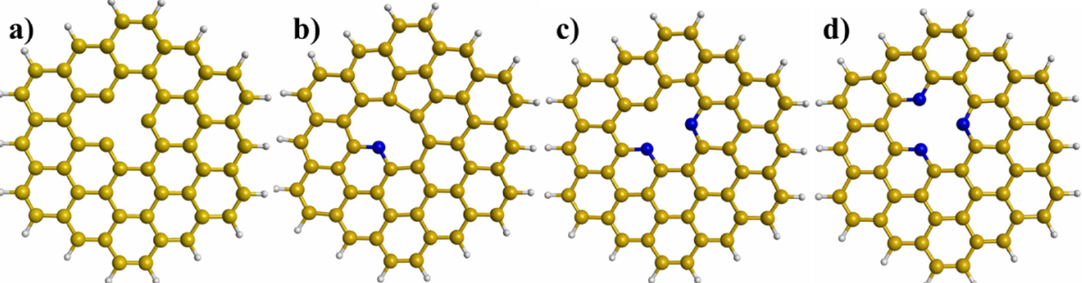
Figure 1. Structures of graphene with different defects: ( a ) Graphene with a vacancy, ( b ) pyridinic N-doped graphene (PNG) with an N atom, ( c ) PNG with two N atoms, and ( d ) PNG with three N atoms.